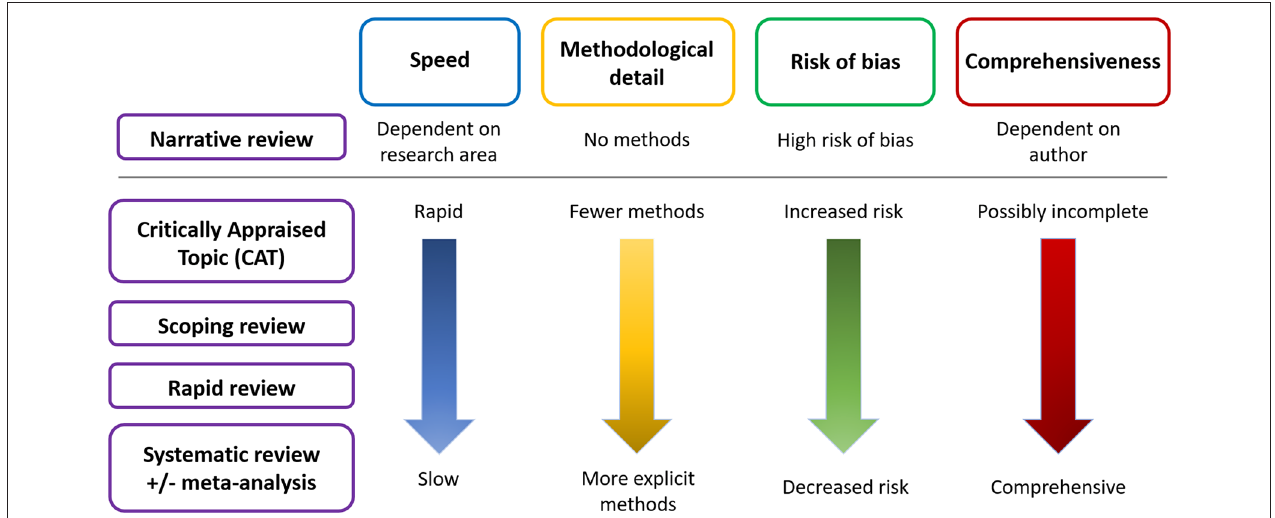
FIGURE 1 | Schematic of the main differences between the types of literature